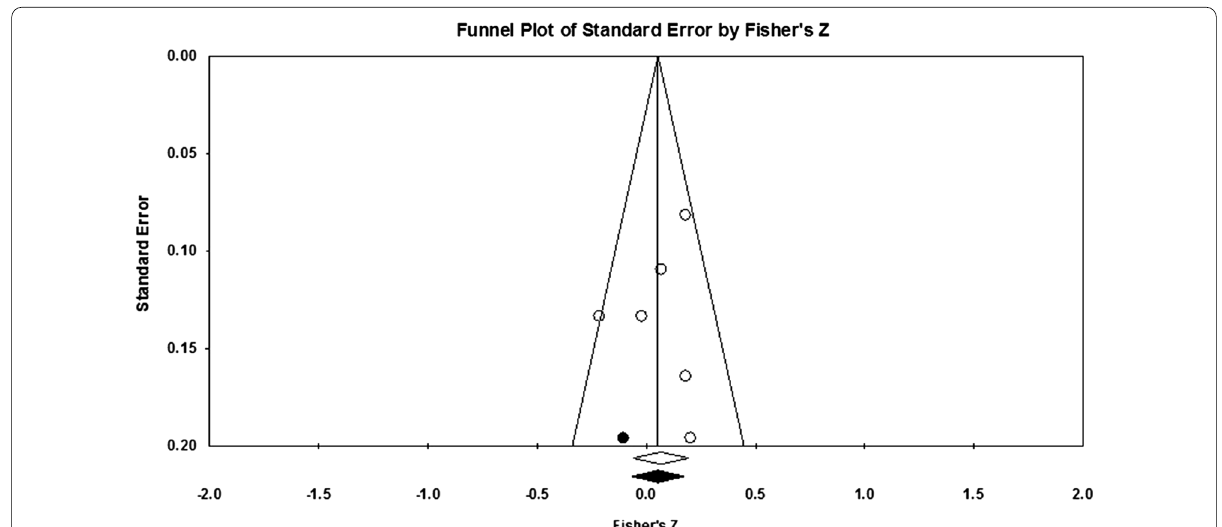
Fig. 6 Funnel plot: Publication Bias and Average IQ. Note. The funnel plot demonstrates standard error estimates from actual and imputed (e.g., missing) studies; the former is indicated by white and the latter is indicated by black dots. The black-filled dot to the left of the axis suggests a study that shows a negative correlation between average member IQ and the criterion task could be missing from this review (e.g.,